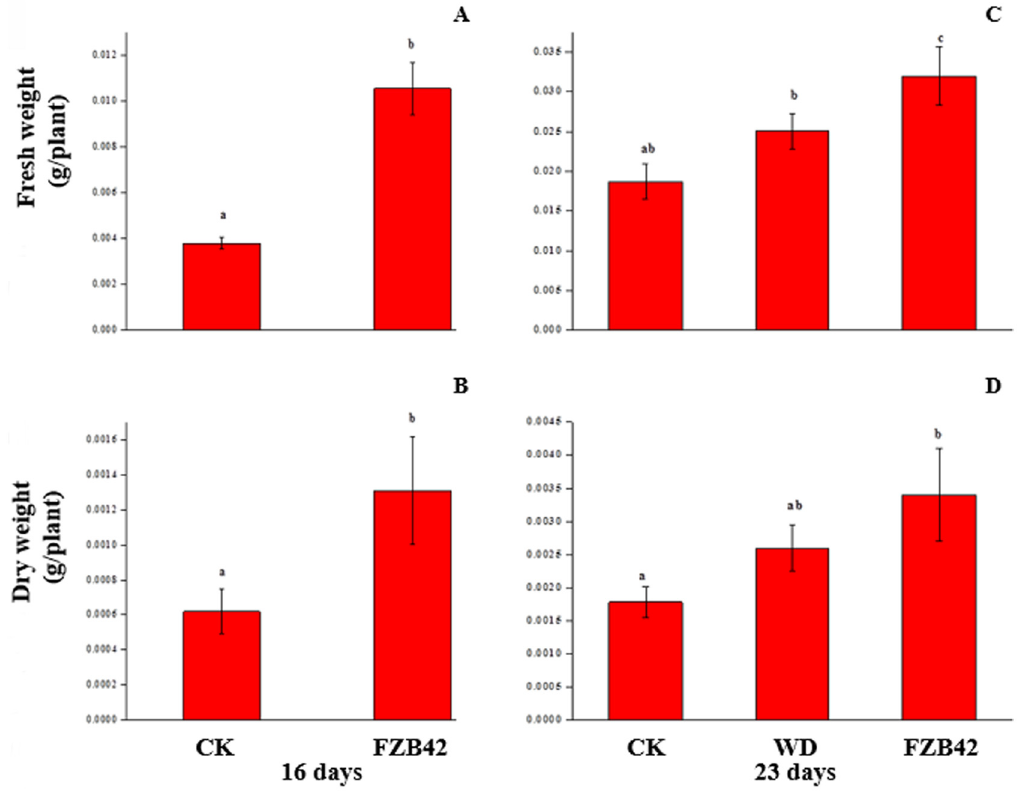
Fig 1. A, B, C and D. An increase in plant growth with sustained Bacillus amyloliqefaciens FZB42 exposure compared with FZB42 withdrawn at 16 day and water-treated controls as determined by fresh weight and dry weight. Fresh weight [A], and dry weight [B] for 16-days plants continuous exposed to FZB42 volatiles (n (cid:1) 10) or water controls (n (cid:1) 10). Fresh weight [C], and dry weight [D] for 23-days old plants continuous exposed to FZB42 volatiles (n (cid:1) 10), FZB42 withdrawn at 16 day (n (cid:1) 10) and water controls (n (cid:1) 10). Different letters indicate significant differences between treatments (ANOVA, p (cid:4)